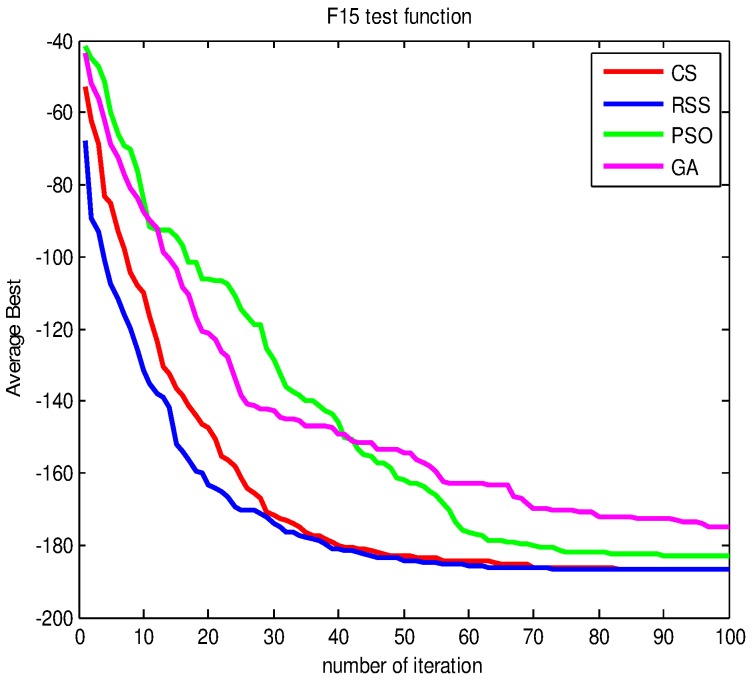
AB convergence of CS, RSS, PSO and GA for minimization of F15.